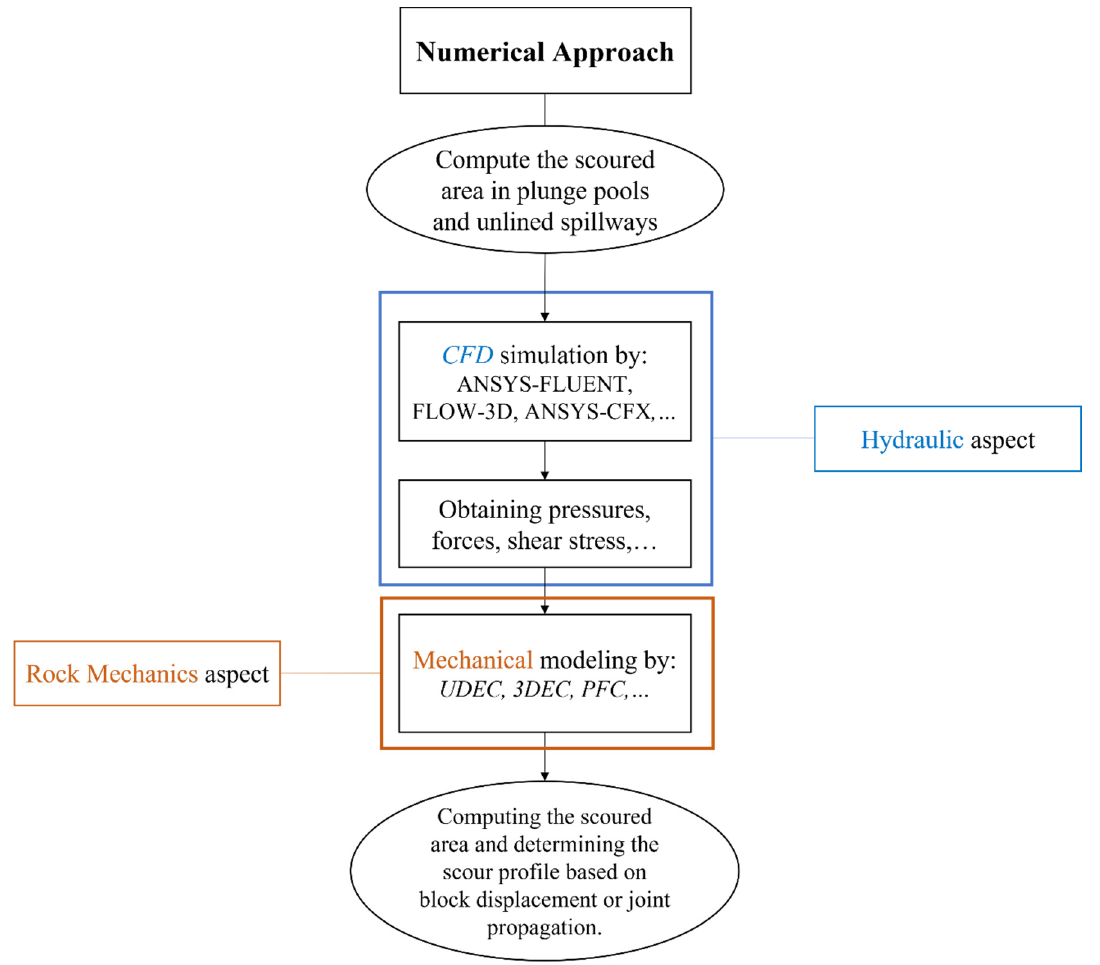
Figure 17. Flowchart of the numerical approach.